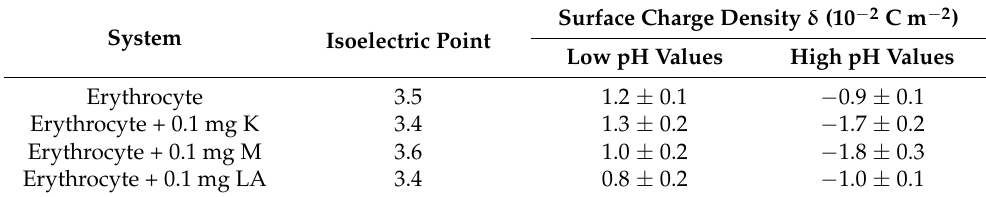
Figure 6. Membrane surface charge densities vs. the pH of the electrolyte solution for erythrocyte, Table 1. The surface charge densities and isoelectric points for the erythrocyte and erythrocyte + 0.1 mg K, M, LA system.